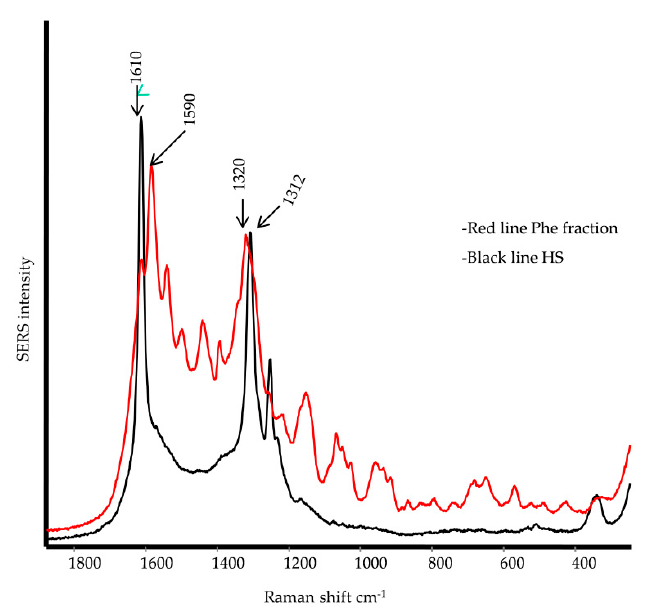
Figure 3. Surface-enhanced Raman scattering (SERS) spectra of soil water soluble phenolic (SWSP) Figure 3. Surface ‐ enhanced Raman scattering (SERS) spectra of soil water soluble phenolic (SWSP) fraction (red line) and humic substances (HSs). fraction (red line) and humic substances (HSs).